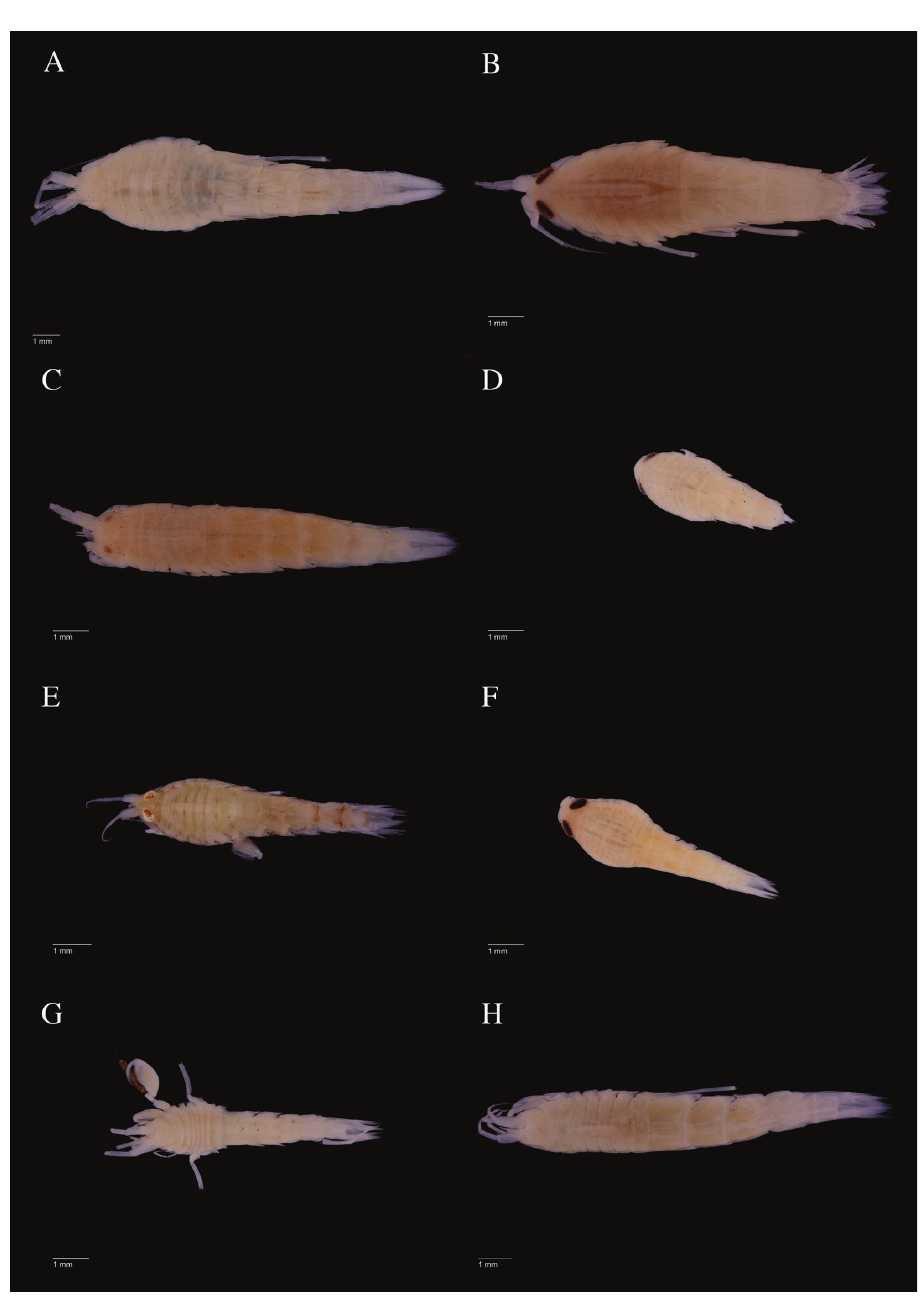
Figure 5. Dorsal view photos of IceAGE material representing different clades in the analyses. A Rha- chotropis gislii AMPIV004-17 B R. helleri AMPIV233-17 C R. aff. helleri AMPIV011-17 D R. inflata AMPIV070-17 E R. northriana AMPIV225-17 F R. oculata AMPIV 228-17 G R. aff. palporum AM- PIV033-17 H R. aff. proxima AMPIV005-17 I R. cf. proxima AMPIV002-17 J R. sp. B AMPIV009-17 K R. thordisae AMPIV007-17 L R: thorkelli